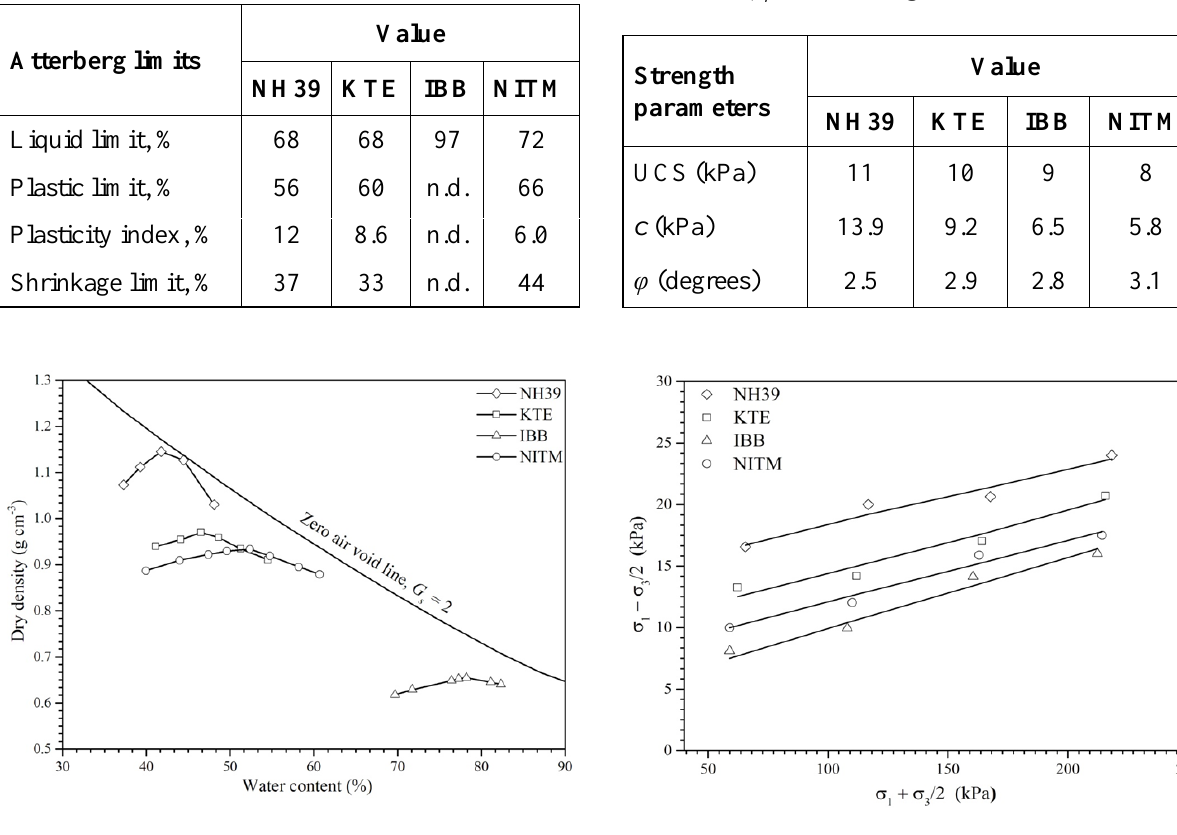
Figure 4. Modified failure envelopes for Northeast Indian